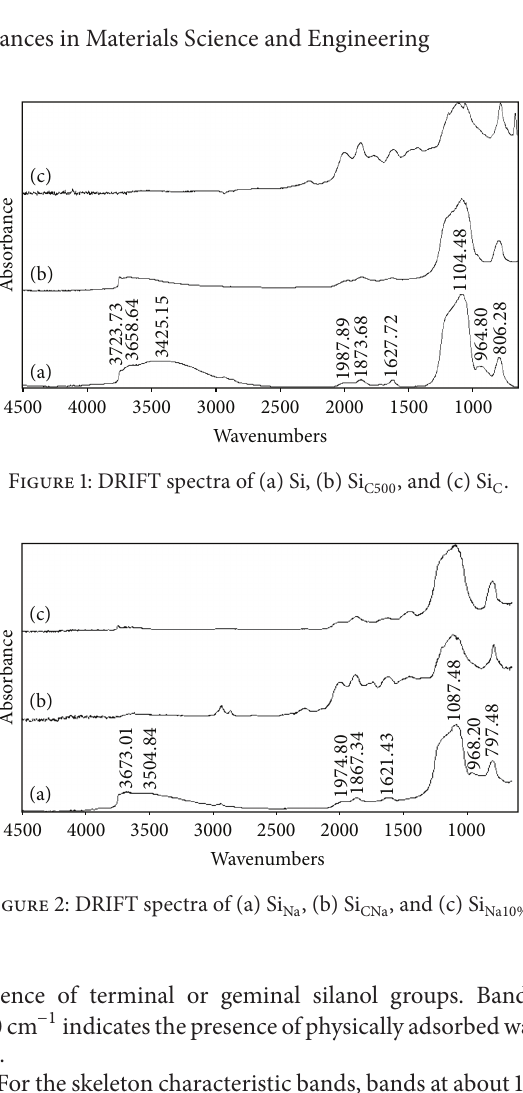
presence of terminal or geminal silanol groups. Band at 1630 cm −1 indicates the presence of physically adsorbed water [30].